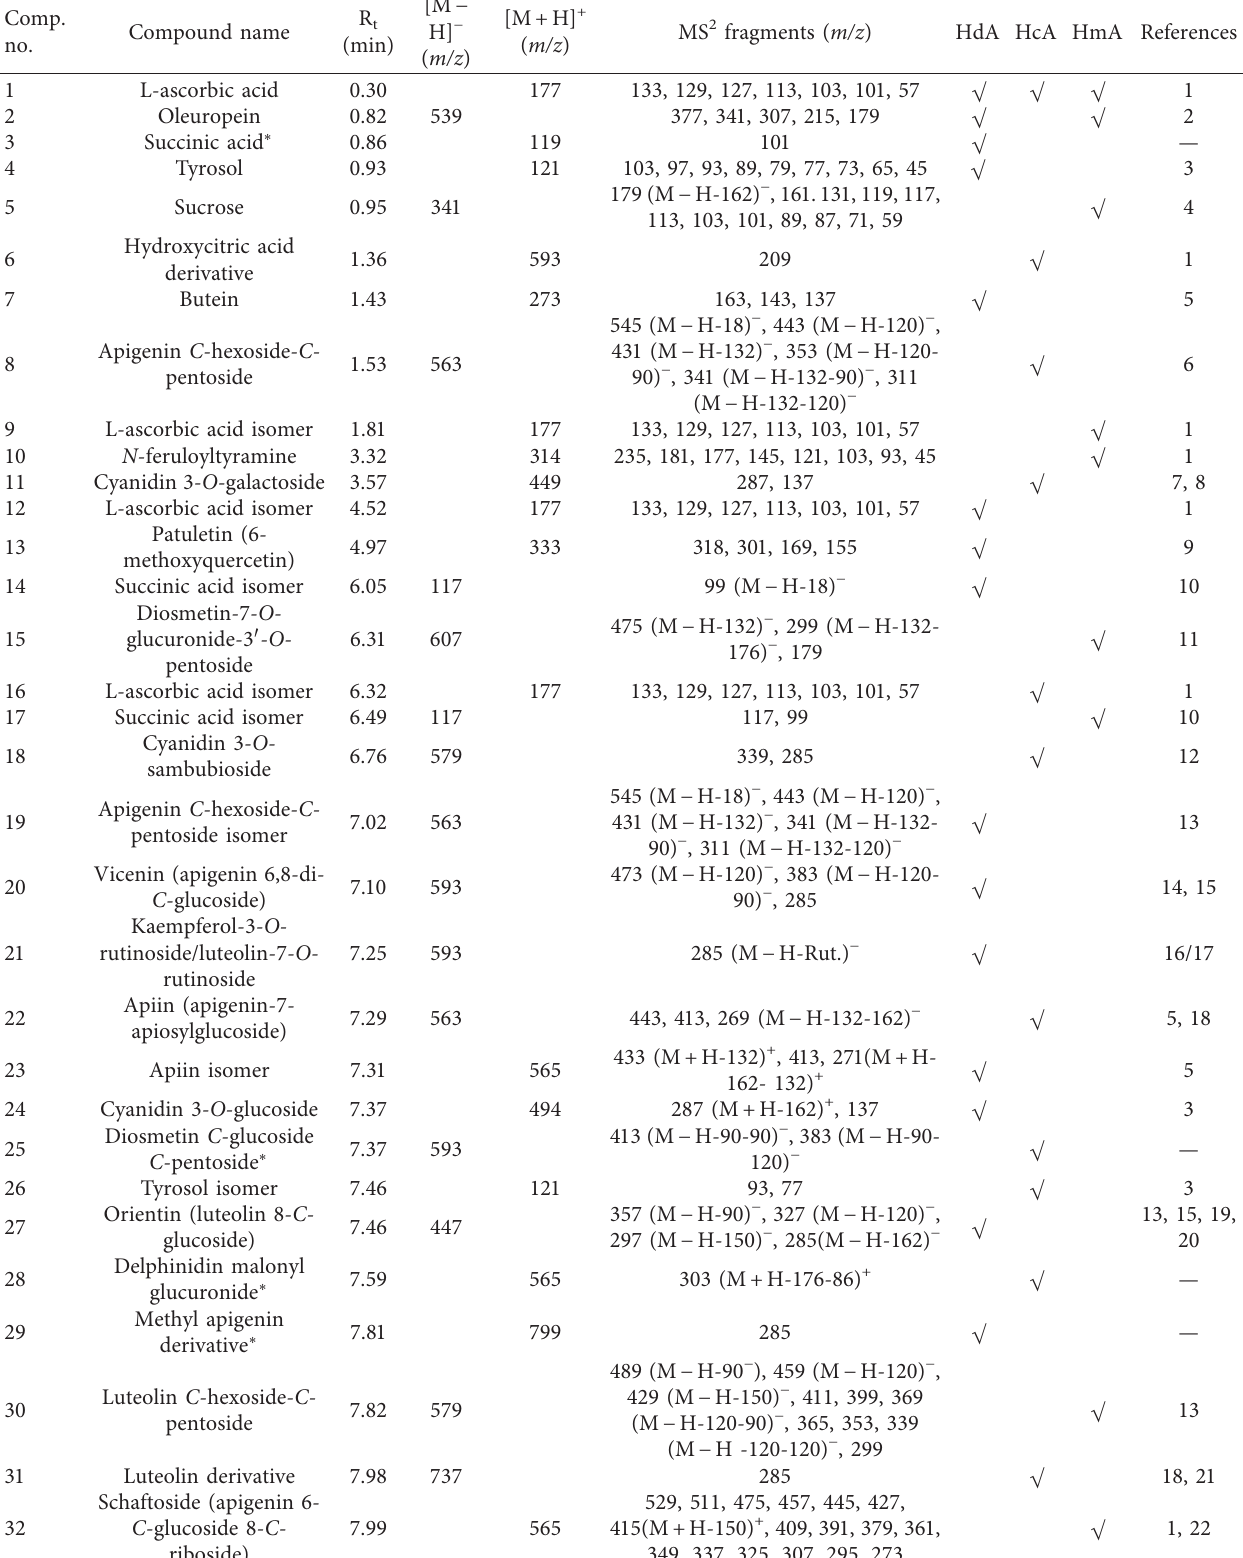
Table 1: Metabolites identified in the aqueous extracts of Hibiscus deflersii (HdA), H. micranthus (HmA), and H. calyphyllus (HcA) using UPLC − ESI − MS in negative and positive ionization modes.